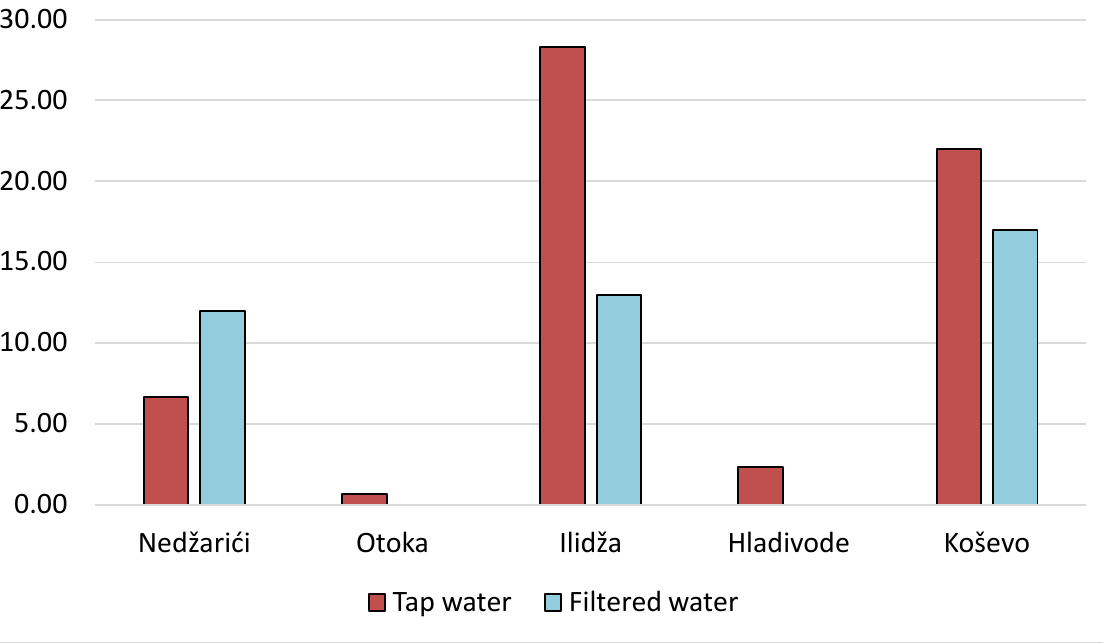
Figure 3. Comparison of CFU for regular and filtered tap